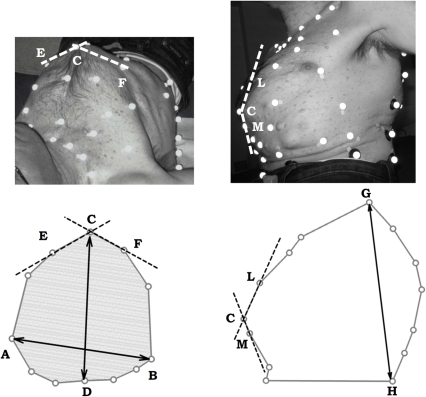
Assessment of chest wall geometry and rib cage deformity by markers' projections.Experimental set-up for the analysis of chest wall volumes via optoelectronic plethysmography in supine (a) and seated (b) position on a representative OI type III patient. c: schematic view of the markers on the transversal plane at the xiphosternal level, in which medio-lateral diameter (distance between markers A and B), antero-posterior diameter (distance between markers C and D), area (grey area) and transversal angle (angle formed between lines CE and CF) are shown; d: schematic view of the markers on the sagittal plane in which trunk height (distance between markers G and H), and sagittal sternal angle (enclosed within lines CL and CM) are shown.